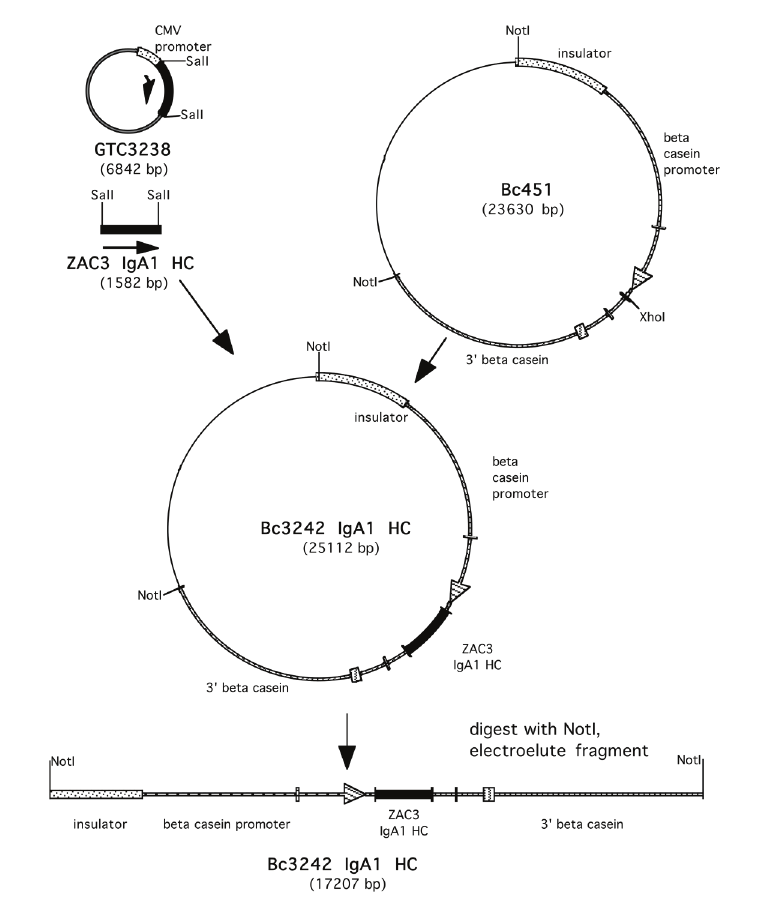
Supplementary Figure 2. Construction of BC3235 IgA1 LC. The VL sequence was also obtained from the published sequence, (with a 2 amino acid deletion at aa87). The protein was reverse translated, opti- mized for mammalian expression, and synthesized by GeneArt, (ThermoFisher), linked to the K constant region. The gene was present as a 500 bp SalI fragment in the pcDNA3 expression vector BC3232. The 500 bp fragment was released by digesting with SalI and ligated into the XhoI site of BC2797 to yield BC3235 IgA1